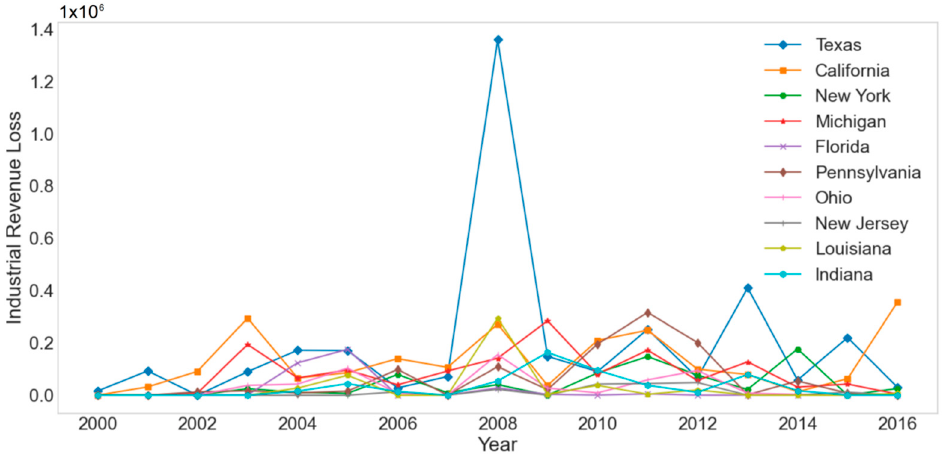
Figure 11. Revenue loss in industrial sector for top 10 individual states during 2000–2016 due to power outages.